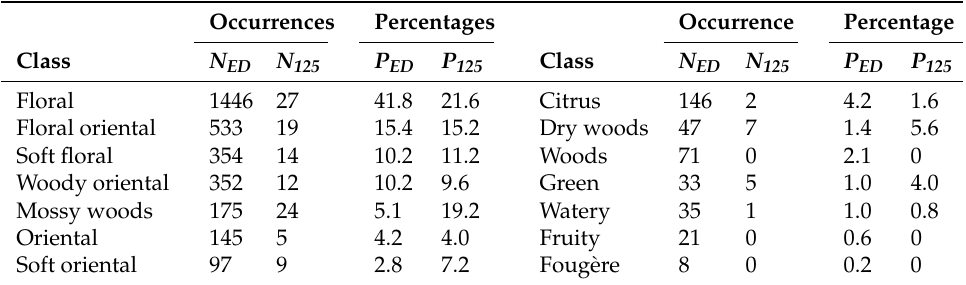
Table 4. Number of feminine fragrances ( N ED ) listed under each class of the directory published by Edwards in 2008 (3463 in total). Classification of those 125 perfumes studied here that are contained in this directory (number of occurrences: N 125 ). Frequencies in percentage are also